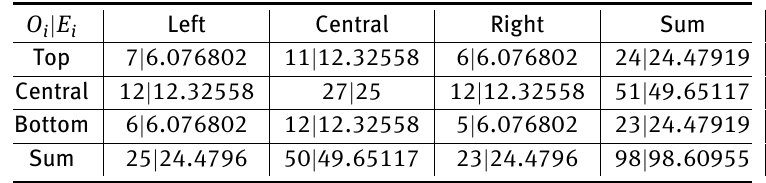
Table 2: Observed and expected values for the data in Example 2.1 and the regions determined by the empirical BBP in option 1.